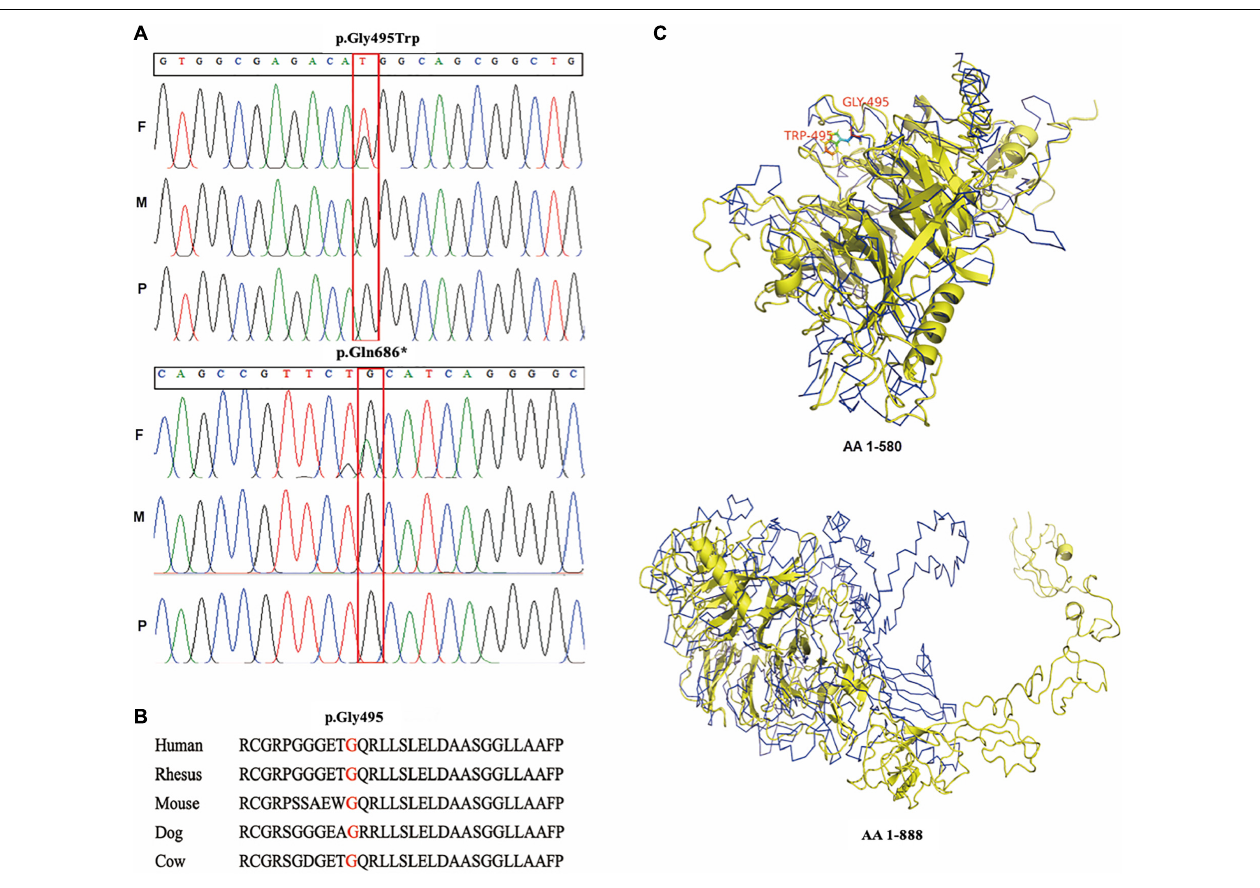
FIGURE 2 | Genetic variants detected in the patients and in silico prediction. (A) Sanger confirmation of two SEMA6B variants in the patients and their parents; (B) conservation of p.Gly495 in mammals; (C) upper: protein tertiary structure of amino acid residues 1–580; lower: full-length protein tertiary structure (amino acids